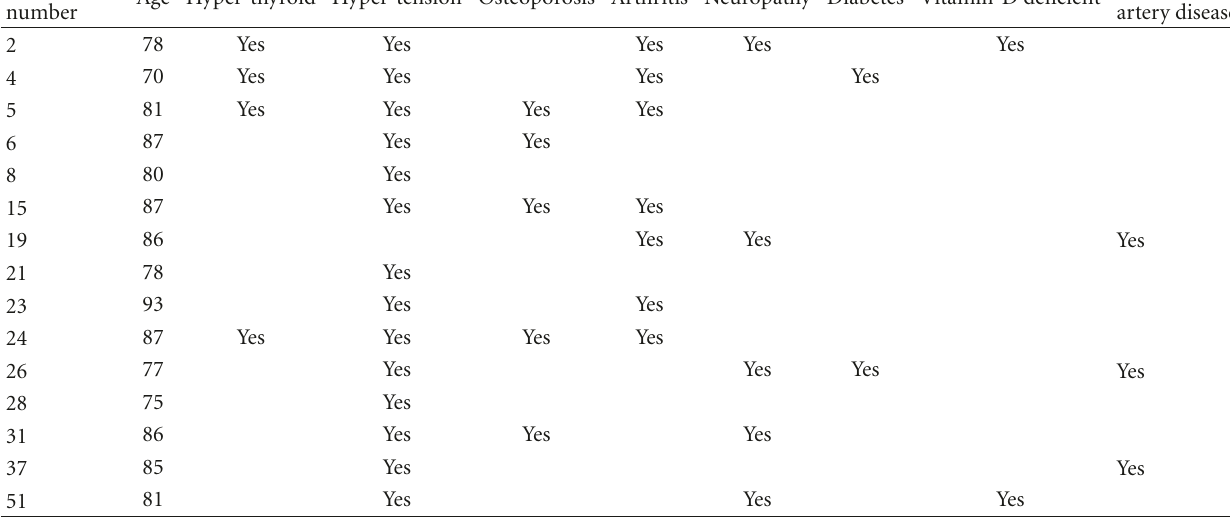
Table 2: List of comorbidities for subjects that lie outside the normal distribution of